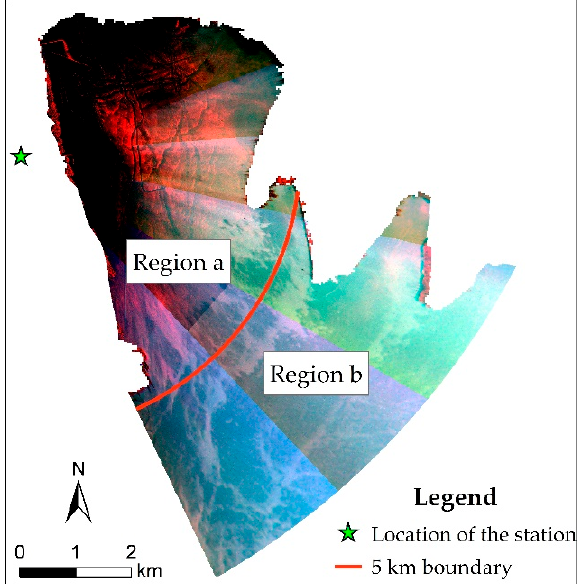
Figure 3. False-color image and regional division of multispectral remote sensing from Dianchi